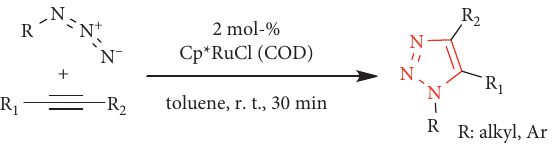
Scheme 7: Ruthenium-catalyzed azide-alkyne cycloaddition.